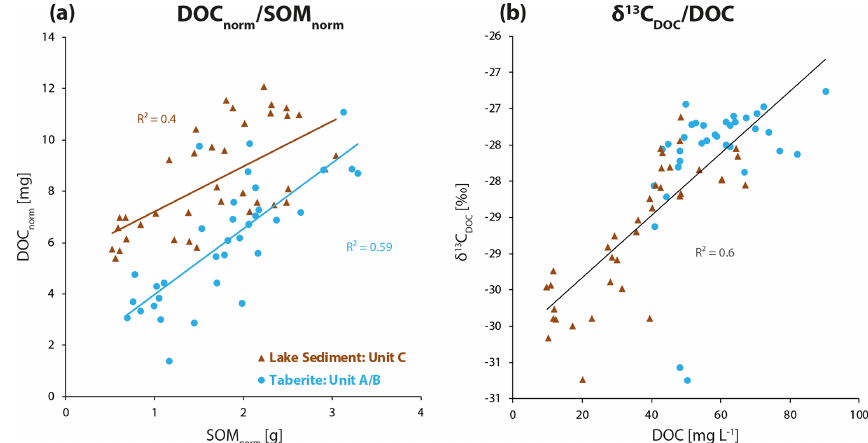
Figure 5. (a) DOC norm [mg] displays porewater DOC in mass units instead of concentrations. It shows that the total amount of DOC present in the lake sediment is higher than in the taberite. At the same time the total amount of SOM norm [g] ranges in the same order of magnitude in both facies. (b) DOC concentrations are the highest in the taberite while DOC concentrations in the lake sediment have a broader concentration range. At the same time there is a trend across the complete talik profile of higher δ 13 C DOC values with higher DOC concentrations.